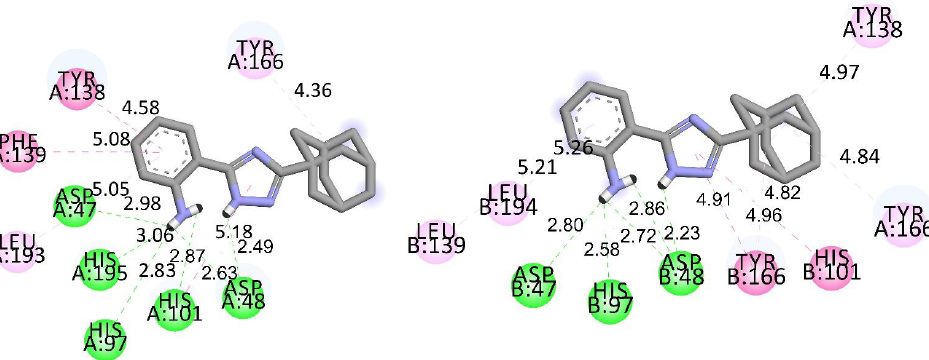
Figure 5. Calculated bonds and interactions (2D) of triazole 5 toward amino acid residues in CDA active sites of A. niger ( Ang CDA; left) and of A. nidulans ( An CDA; right); bond distances indicated in Å. Green: Conventional Hydrogen Bond; magenta: π - π T-shaped/Amide- π Stacked/ π - π Stacked; pink: π -Alkyl (Tables S10 and S11, Supplementary Material).